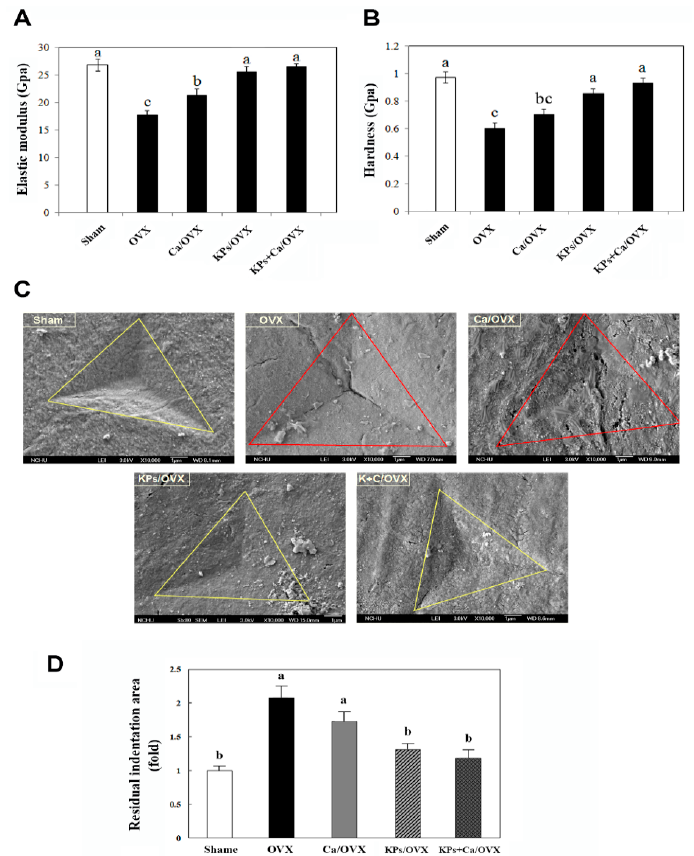
Figure 3. Nanoindentation analysis of the mechanical properties of cortical femoral bones at the end of oral administration. Each sample was analyzed by at least three series of outer-to-inner indentation tests (15 points) across the transverse section of the cortical bone shell (130–160 μ m in thickness). The mechanical properties of the elastic modulus ( A ) and hardness ( B ) were compared among the groups. ( C ) The indented surfaces were further examined by scanning electron microscopy. The residual nanoindentation areas are marked by triangles and were quantitated using ImageJ software. The relative residual nanoindentation areas were calculated by comparison with the sham group ( D ). The data are presented as means ± SEM ( n = 6). Statistical analysis was performed by one-way ANOVA and Duncan’s post hoc test, and statistical significances are indicated by different letters ( p < 0.05). Table 1. The mean α - and β -diversity indices and the P values for various group comparisons. α -Diversity Index β -Diversity Index